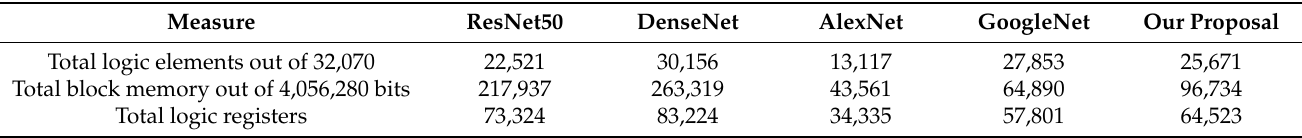
Figure 8. Numbers of resources for DE1-Soc.